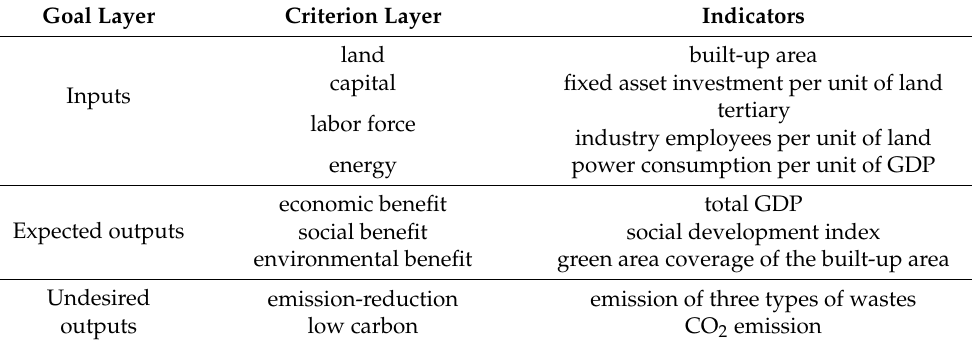
Table 2. ULUE index